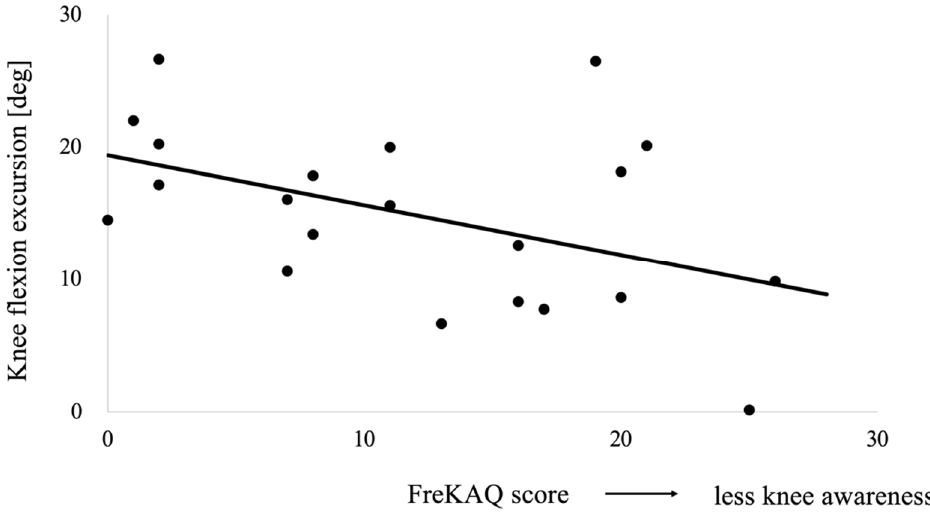
Figure 3. The relationship between the knee flexion excursion in loading response at fast speed and the Fremantle Knee Awareness Questionnaire (FreKAQ) score. High FreKAQ score indicates less knee awareness.